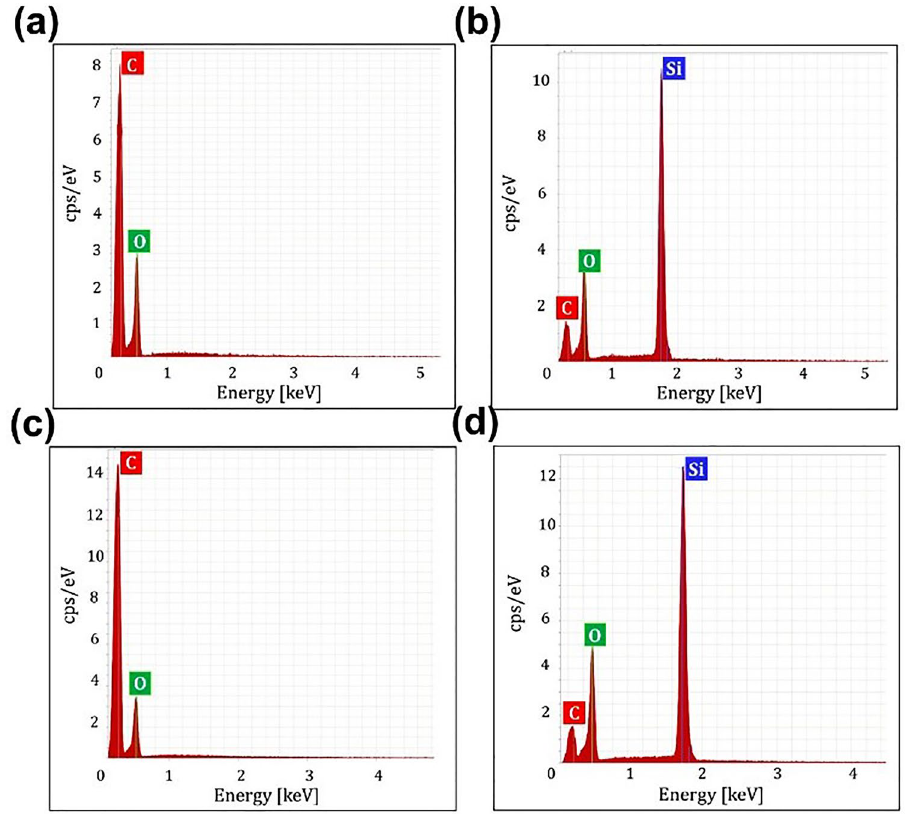
Figure 2. Energy-dispersive X-ray spectra of ( a ) PMMA, ( b ) PDMS, ( c ) acrylic-based PSA, and ( d ) silicon- based PSA. The presence of carbon (C) and oxygen (O) peaks from PMMA and acrylic-based PSA samples indicates that they are acrylic-based materials, whereas Si peaks from the PDMS and silicon-based PSA samples confirm their silicon-rich nature.